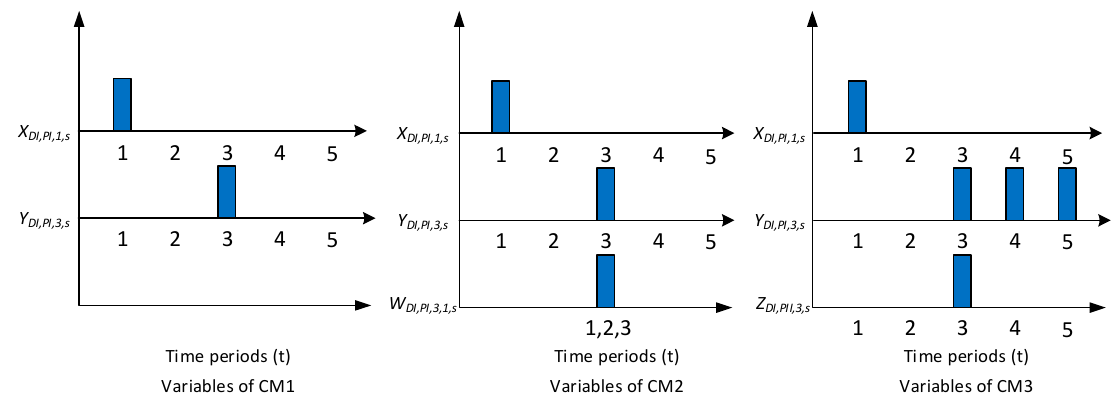
Figure 2. Comparison of scheduling variables in CM1, CM2 and CM3 formulations.